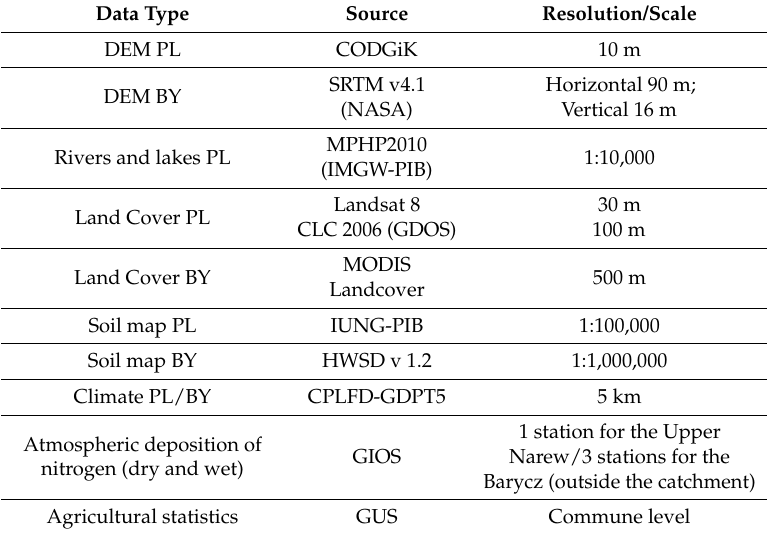
Table 3. Data items and sources used to create the SWAT model setup of the Upper Narew and Barycz